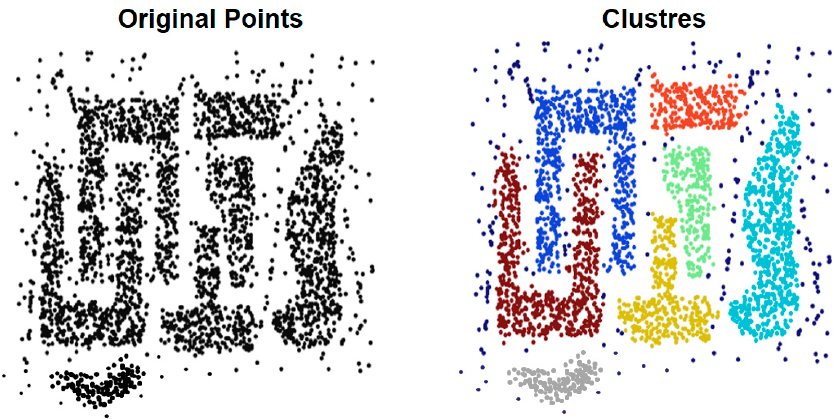
Figure 1. This figure (modified from [8]) shows the functionality of DBSCAN algorithm, after applying DBSCAN, the noises can be excluded and the points can be classified to